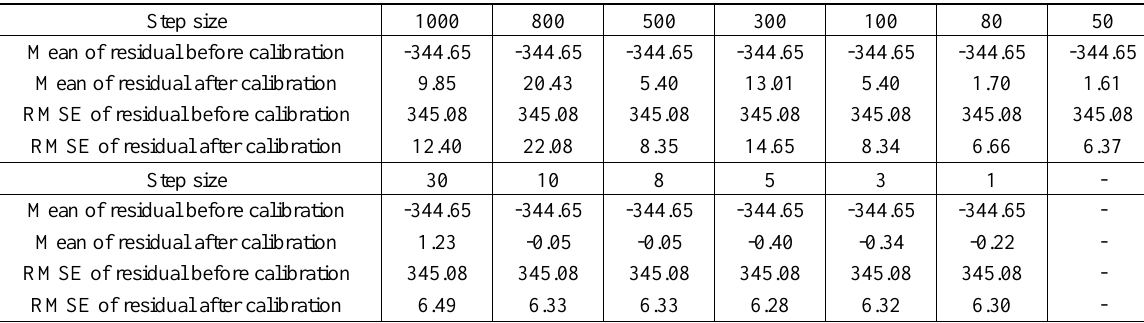
Table 6. Step size change and calibration effect analysis.